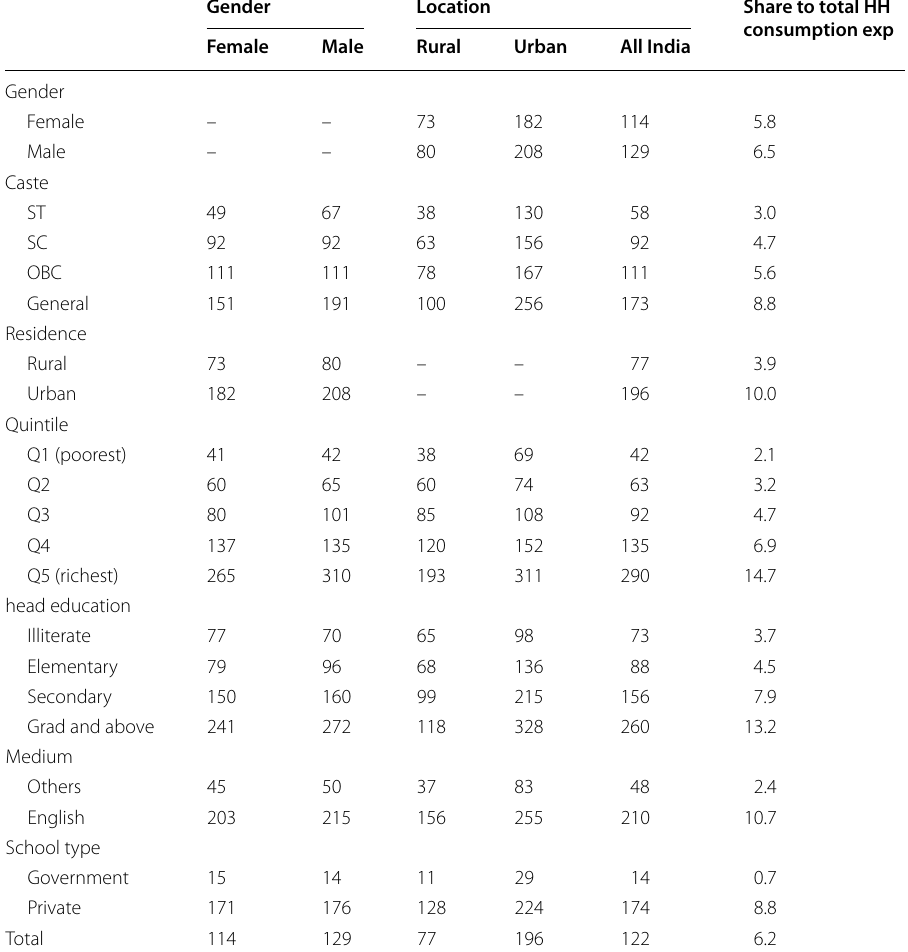
Table 5 Household spending ($) on pre-primary education in India by gender and location